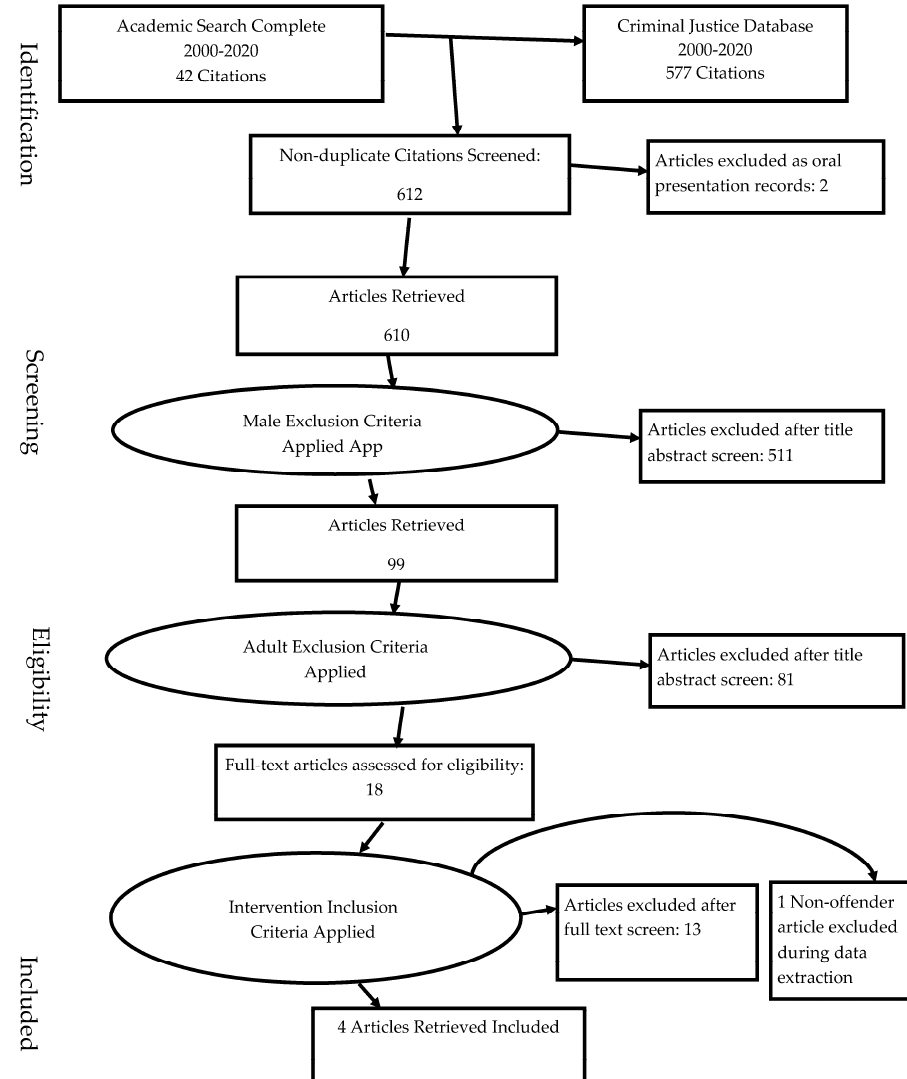
Figure 1. The Roberts-Lewis and colleagues’ study featuring a multi-component substance abuse protocol, (2) the Harold and colleagues’ study using multi-dimensional treatment in foster care